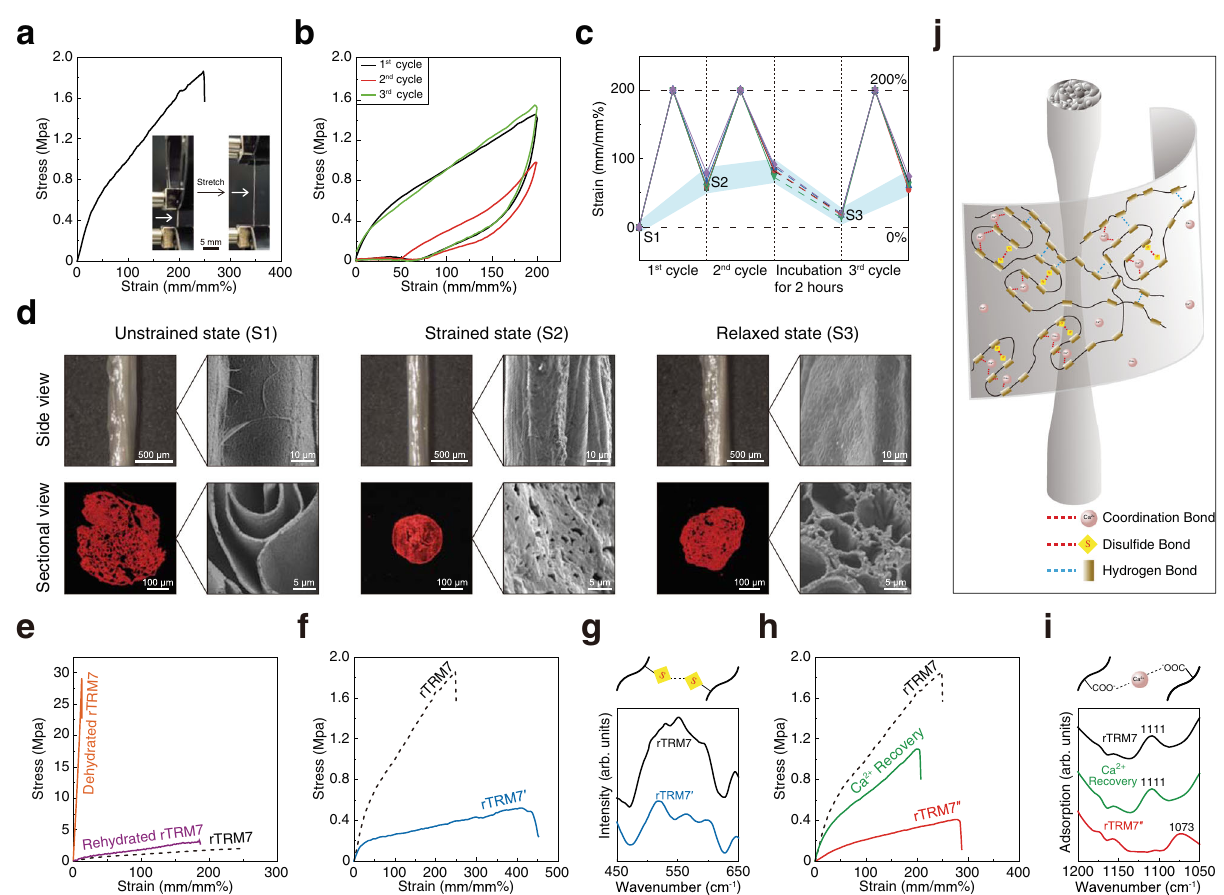
Fig. 3 Mechanical properties investigation of rTRM7 fi ber. a A typical strain-stress curve of the rTRM7 fi ber stretched to rupture in wet condition. Inside images are an rTRM7 fi ber before and after stretching. b Strain-stress curves of the rTRM7 fi ber under cyclic tensile test at maximum strain of 200%. c Length change recording for rTRM7 fi bers ( n = 5) referring to initial state in a cyclic tensile test corresponding to the cyclic tensile test shown in fi gure b . S1 is unstrained state of fresh rTRM7 fi ber. S2 is rTRM7 fi ber after fi rst stretch cycle. S3 is recovered rTRM7 fi ber after a 2-h incubation in CaCl 2 buffer. d Micro images (left) and SEM images (right) of side view (top) and sectional view (bottom) of the rTRM7 fi bers in untrained, strained, and relaxed state corresponding to S1, S2, and S3 in fi gure c . e Representative strain-stress curves of rTRM7, dehydrated and rehydrated rTRM7 fi bers. f Representative strain-stress curves of rTRM7 and rTRM7 ’ fi ber stretched to rupture in wet condition. g Raman spectra of rTRM7 and rTRM7 ’ fi bers corresponding to f . h Representative strain-stress curves of rTRM7, rTRM7 ” , and Ca 2 + recovered rTRM7 ” fi bers stretched to rupture in wet condition. i FTIR adsorption spectrum of rTRM7 fi ber, rTRM7 ” fi ber, and Ca 2 + recovered rTRM7 ” fi ber corresponding to h . The band of carboxy in rTRM7 ” fi ber at 1073 cm − 1 blue shifted to 1111 cm − 1 indicated calcium-carboxy coordination was removed in rTRM7 ” and recovered in Ca 2 + recovery rTRM7 ” fi ber. arb. units, arbitrary unit. j Schematic illustration of lamellar structure and chemical bonds of recombinant protein fi